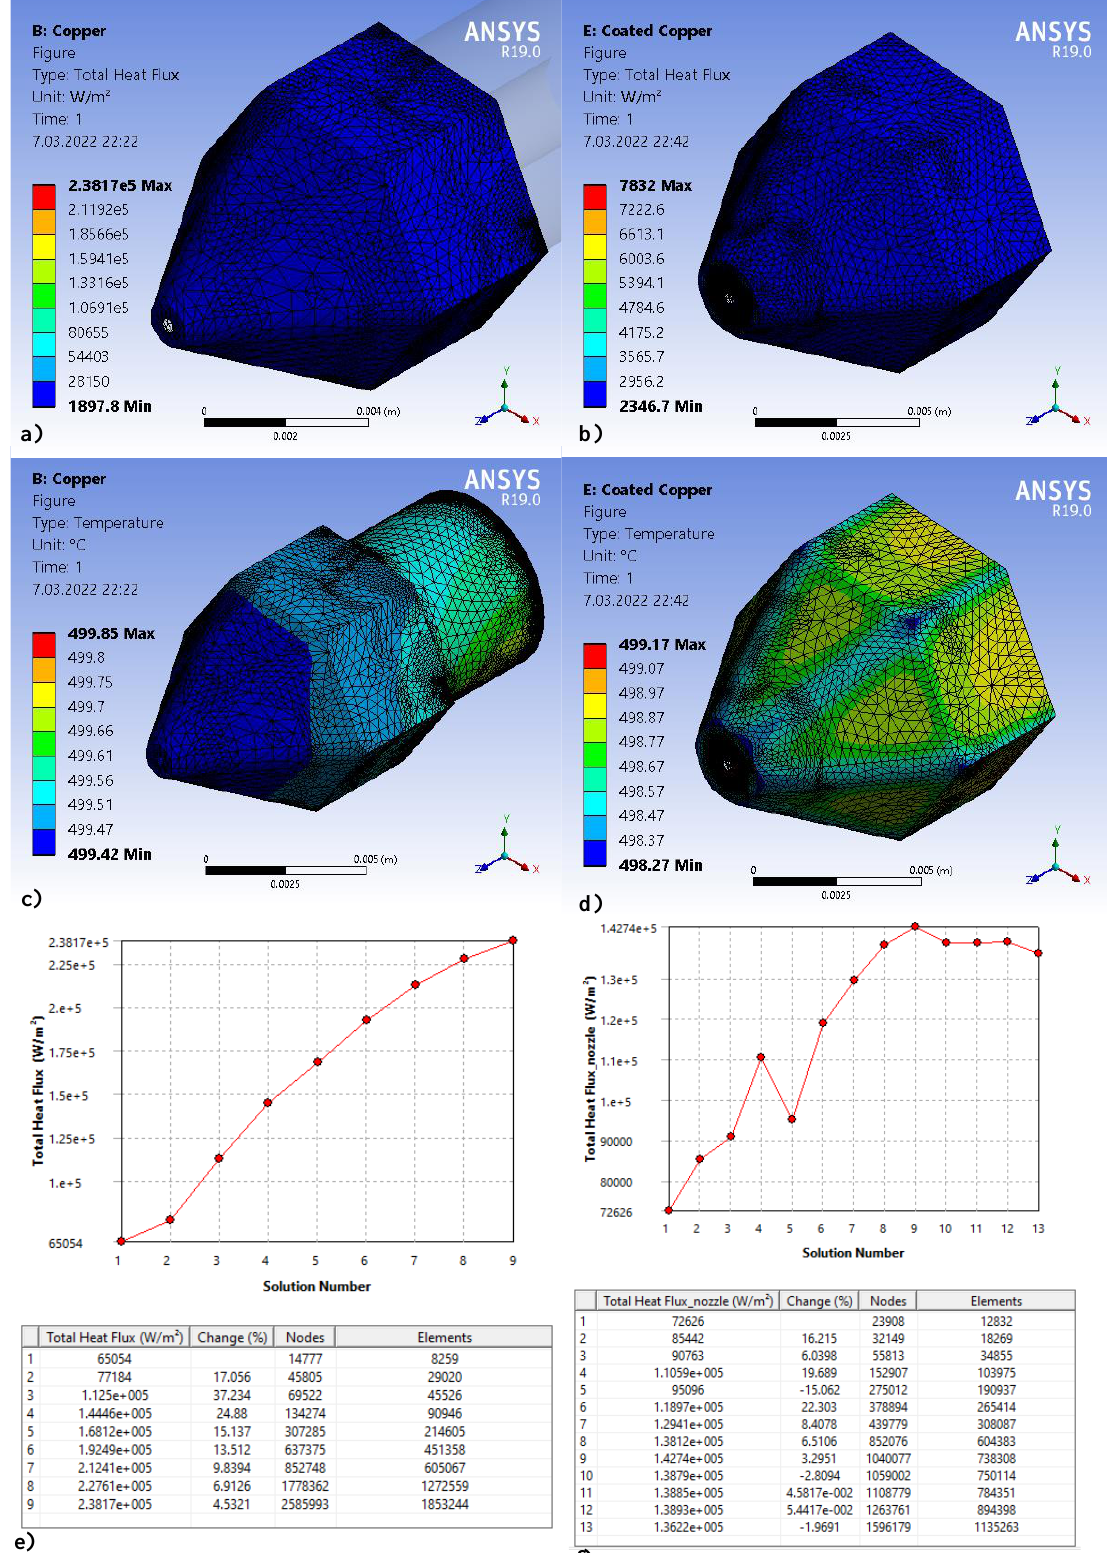
Figure 5. The total heat flux of ( a ) the copper nozzle and ( b ) coated copper nozzle; temperature distribution of ( c ) the copper nozzle and ( d ) the coated copper nozzle; mesh convergence study based on the total heat flux of ( e ) the copper nozzle and ( f ) the coated copper nozzle.